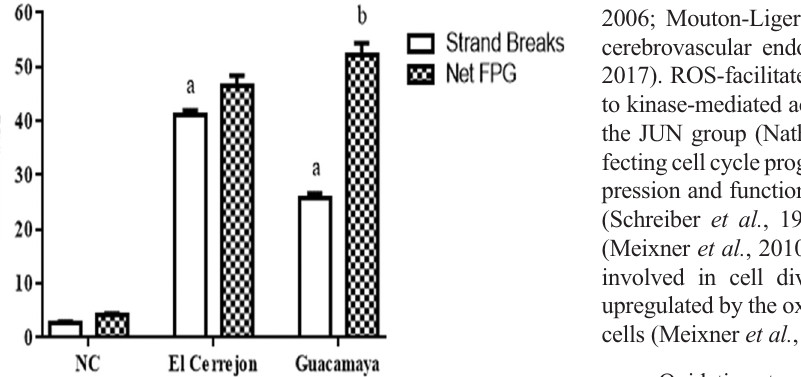
Figure 10 - Percent tail DNA in the alkaline comet assay (strand breaks in white) and oxidized purines (grid) in a modified comet assay with FPG in V79 cells under 24 h exposure with El Cerrejon and Gucamaya coal. a) Statistically significant differences in relation negative control (NC) with- out enzyme P <0.05. b) Statistically significant differences in relation to the same sample group with an enzyme. The results are shown as the mean (cid:7)